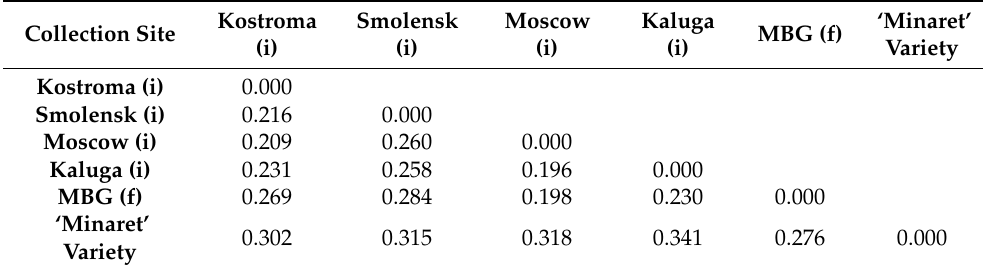
Table 3. Genetic diversity between the analysed populations of L. polyphyllus calculated according to Nei and Li using the combination of methods RAPD, ISSR and REMAP.